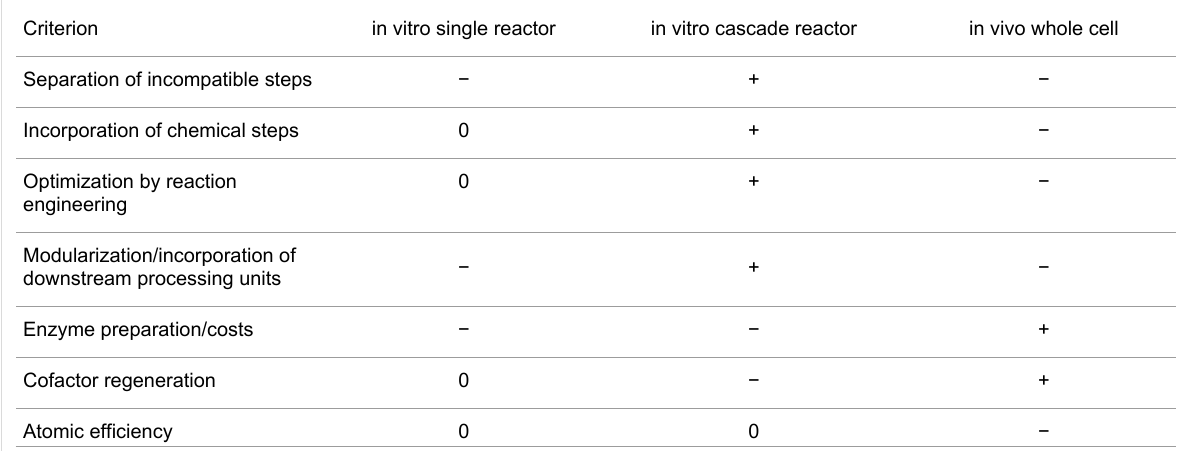
Table 1: Advantages and disadvantages of the three approaches to continuous coupled-reaction (chemo)enzymatic processes. a